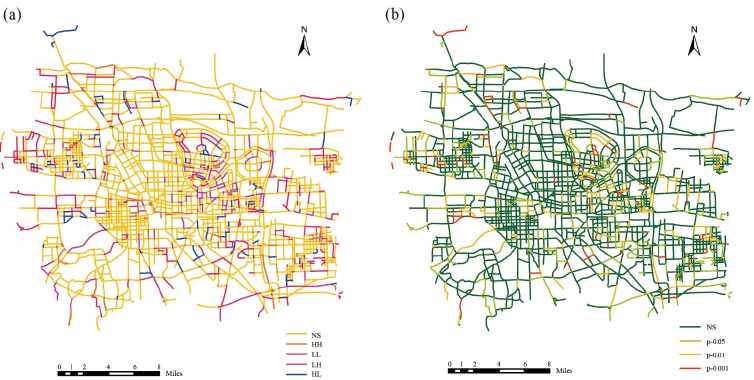
Figure 10. ( a ) LISA clustering map, and ( b ) LISA significance map.